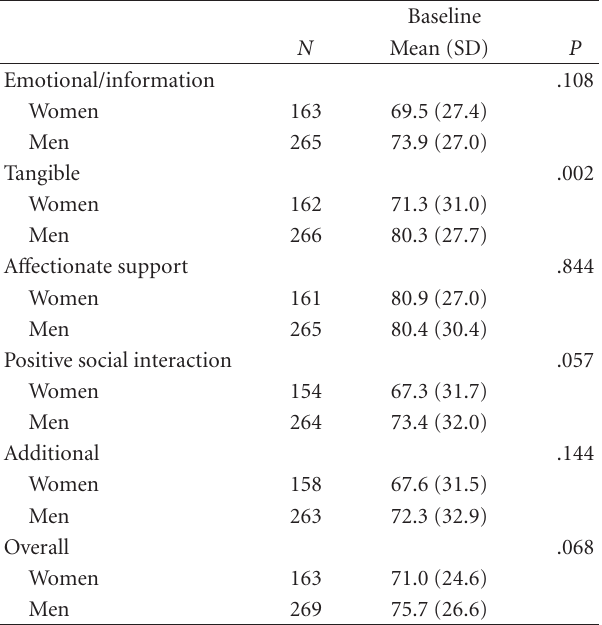
Table 3: Gender di ff erences in baseline social support